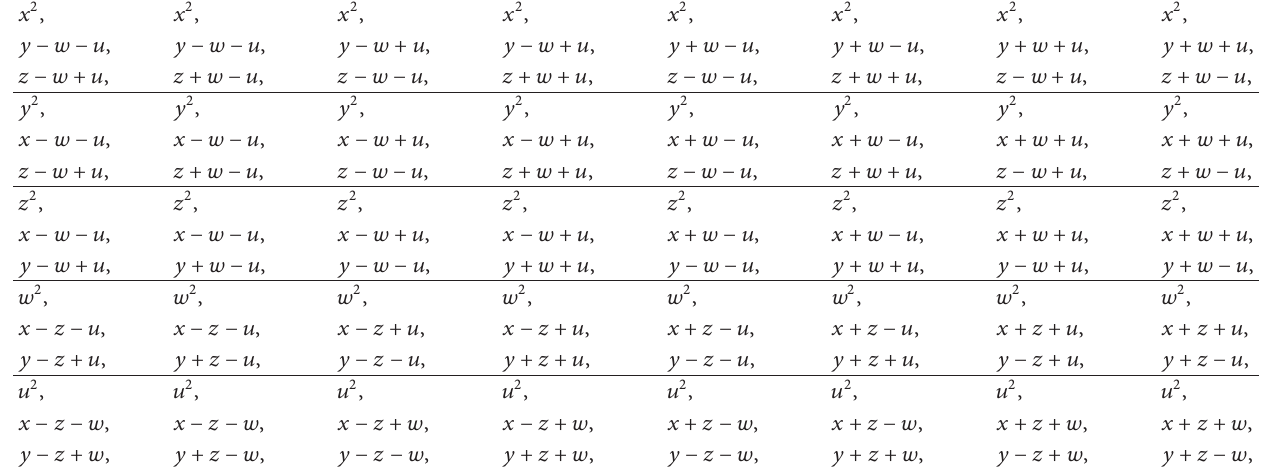
Table 1: Irreducible components corresponding to the projective variety defined by